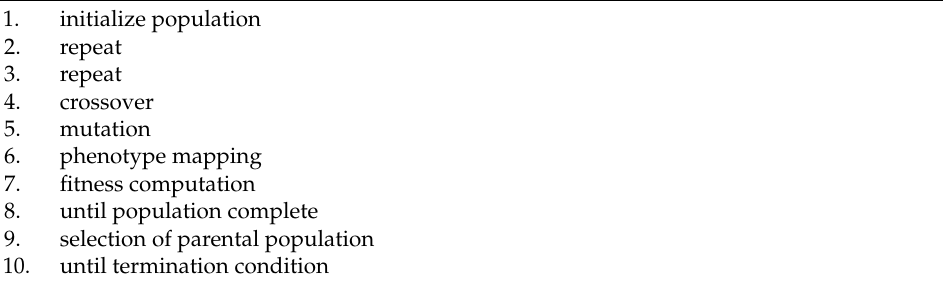
Table 1. Pseudocode of a genetic